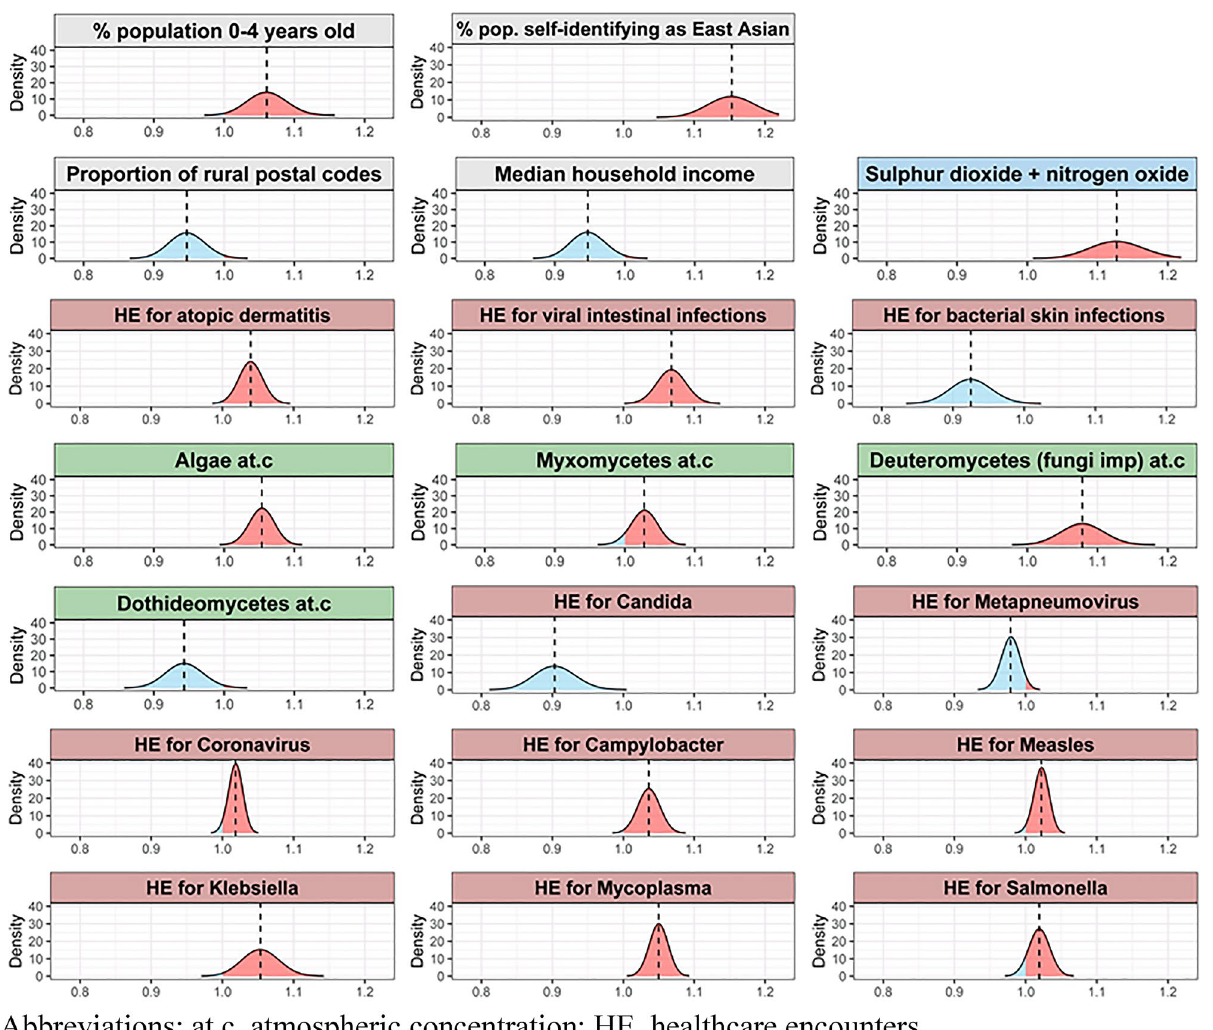
Figure 3. Association of factors with the standardized incidence rate for Kawasaki disease (KD). Distribution of the standardized incidence rate (line = median) based on the posteriors of the fixed effects (same as multivariable results in Table 1). The values represent the change in standardized incidence rates for a 1 standard deviation change in the predictor. A value below 1.0 (blue) indicates a negative association between the predictor and the standardized incidence rate for KD, and values above 1.0 (red) indicate a positive association. The background color of the labels indicates the type of predictor, with grey representing genetic and demographic factors, blue representing atmospheric pollution, red representing the incidence of healthcare encounters for various causes and green representing atmospheric concentration of biological particles. at.c atmospheric concentration, HE healthcare